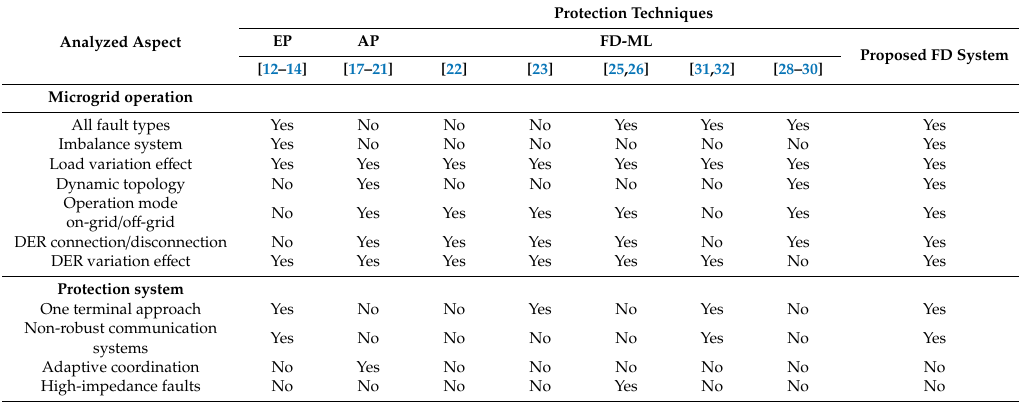
Table 1. Summary of the main aspects of the analyzed protection techniques.